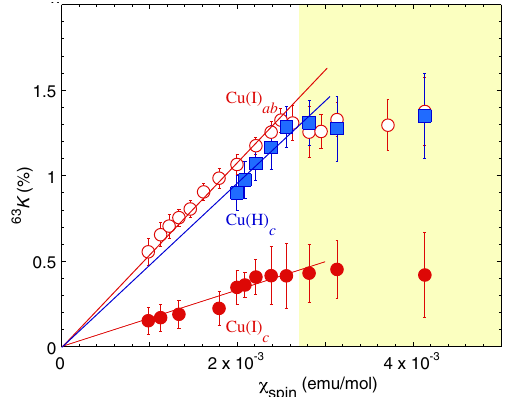
FIG. 10. Separation of the NMR Knight shift 63 K contribution from the second-order quadrupole contribution Δ ν ð the measurements of 63 K linear extrapolation of 63 K gives 63 K.